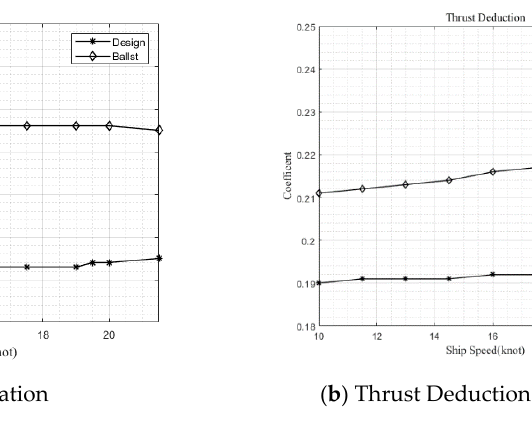
Figure 7. Conventional state of the art (3DDP) routing algorithm. 2.2. Development Speed Control Strategy for Routing Method’s Description In this section, two newly developed speed control algorithms for the route planning of the autonomous vessel are suggested and their methodologies explained. These two algorithms enhance the accuracy of the route decision making of the autonomous vessel making it more practicable in terms of timely arrival condition and reduced fuel consump- tion and gas emissions. The newly proposed algorithms are the modified fixed power control and the wave feed-forward speed control. In Sections 2.2.1 and 2.2.2, the two pro- posed methods are described in detail.